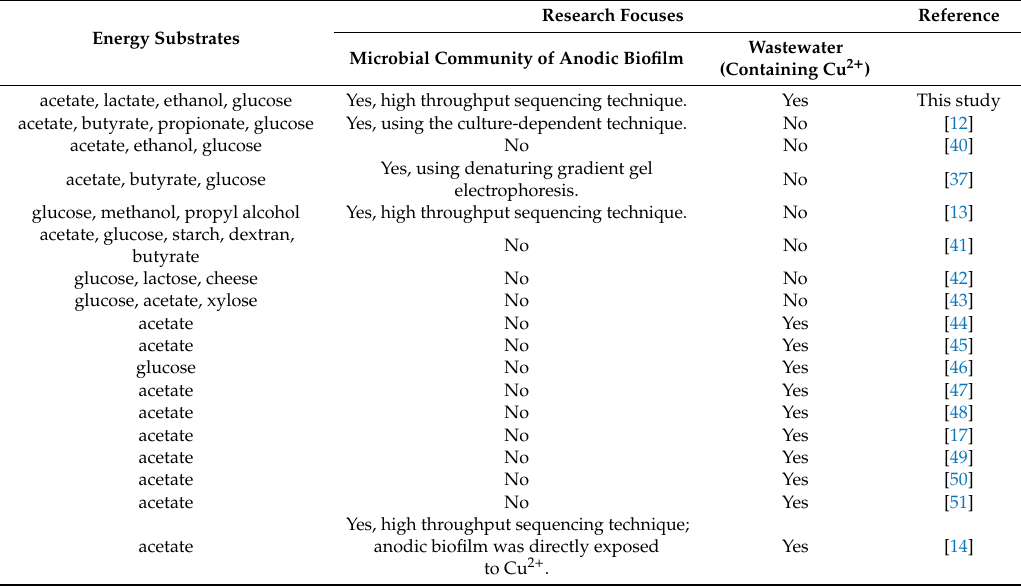
Table 3. Comparison of this study with other related